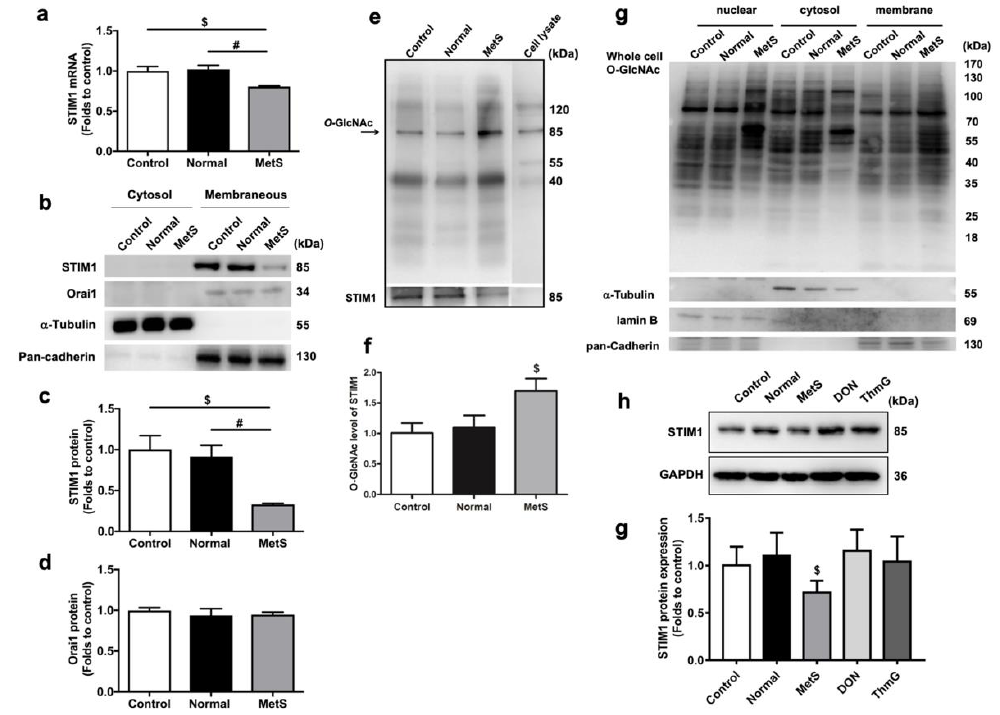
Figure 1. Effects of metabolic syndrome (MetS)-very low-density lipoproteins (VLDLs) on the expression of stromal interaction molecule 1 (STIM1) and calcium release-activated calcium channel protein 1 (Orai1) and the O -GlcNAcylation of STIM1. ( a ) Quantitative RT-PCR of STIM1 ( n = 4 for each group). Reduced STIM1 mRNA in the MetS-VLDL-treated group (MetS) ( $ P = 0.012, # P = 0.005). ( b ) Representative bands of western blots for STIM1 and Orai1 channel proteins. ( c ) Reduced STIM1 membrane protein expression in the MetS-VLDL group ( n = 4 for each group; $ P = 0.025, # P = 0.021). ( d ) Orai1 channel membrane protein expression among groups ( n = 4 for each group; P = 0.5223). ( e , f ) Representative immunoblots and densitometry analysis ( n = 4 for each group). Although STIM1 protein expression was reduced, the O -GlcNAcylation (85 kDa, indicated by the arrow) was larger in the MetS group. $ P = 0.038 for the MetS group versus the control. All of the changes in the MetS group were absent in the normal-VLDL group (Normal). ( g ) Whole-cell O -GlcNAcylation immunoblotting showed enhanced O -GlcNAcylation of the nuclear, cytosol, and membranous protein fractions in the MetS groups. ( g , h ) The inhibition (with 5 μM deoxynorleucine (DON)) and enhancement (with 10 nM Thiamet G (ThmG)) of O -GlcNAcylation did not affect the expression of STIM1.